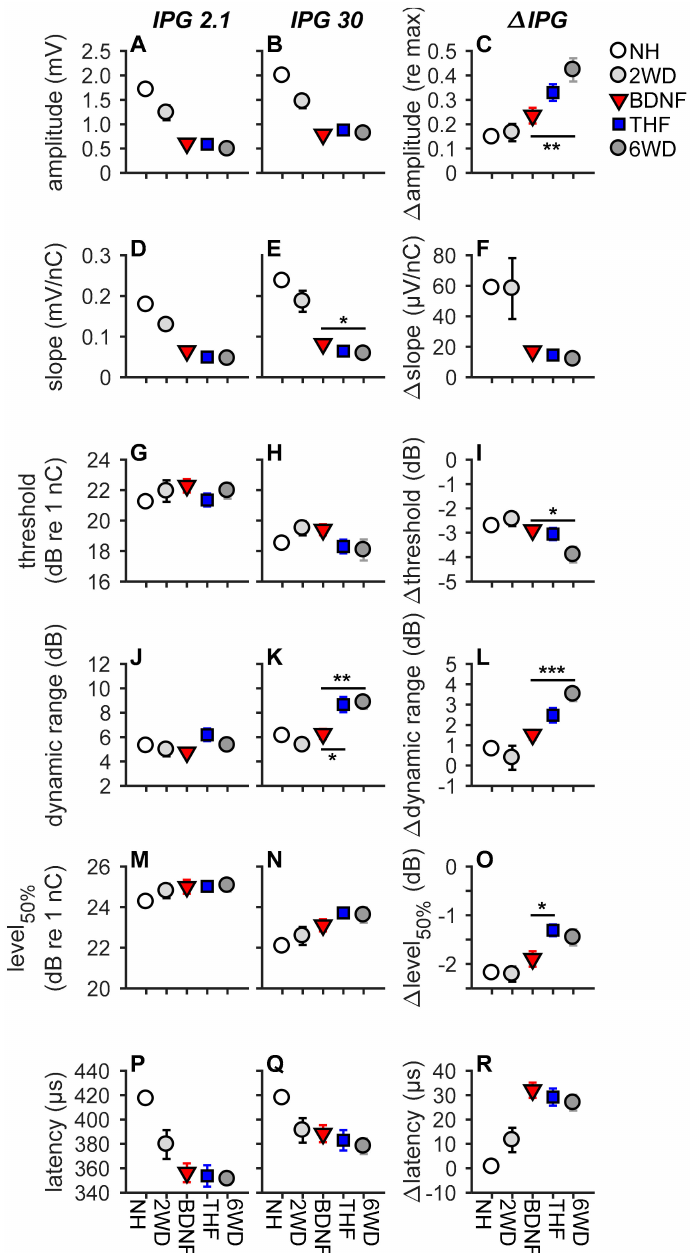
Figure 7. eCAP characteristics for each experimental group. The inter-phase gap (IPG) in the biphasic current pulse was 2.1 µ s in the left column and 30 µ s in the middle column. The di ff erence between the two (i.e., the IPG e ff ect) is shown in the third column. ( A – C ), maximum amplitude; ( D – F ), slope; ( G – I ), threshold; ( J – L ), dynamic range; ( M – O ), level 50% ; ( P – R ), N 1 latency. Data of the 2WD animals was used from Ramekers et al. [48]. NH, n = 9; 6WD, n = 12 ( n = 13 for latency); BDNF, n = 11; THF, n = 10 ( n = 11 for latency). * p < 0.05, ** p < 0.01, *** p < 0.001. Error bars represent